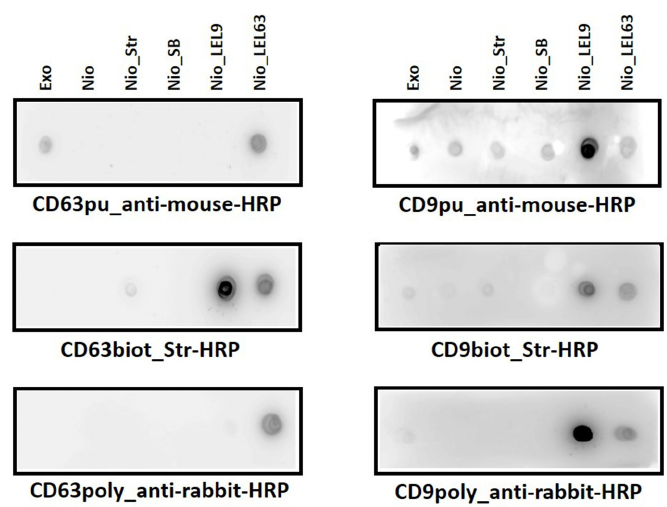
Figure 4. Dot-blot assay for the screening and selection of α -tetraspanin antibodies for their future use in ELISAs for the detection of fully artificial exosomes (Nio_LEL). Secondary antibodies labelled with HRP were appropriately selected. Different negative controls were also introduced (bare niosomes, niosomes functionalized with streptavidin with and without biotin saturation), as the use of a sample of natural exosomes from cell line SUM159 cells derived from triple-negative carcinoma, although expressing mesenchymal markers, as positive control, enriched from cell cultures by differential ultracentrifugation. (pu) purified monoclonal antibody; (biot) biotynilated monoclonal antibody; (poly) polyclonal